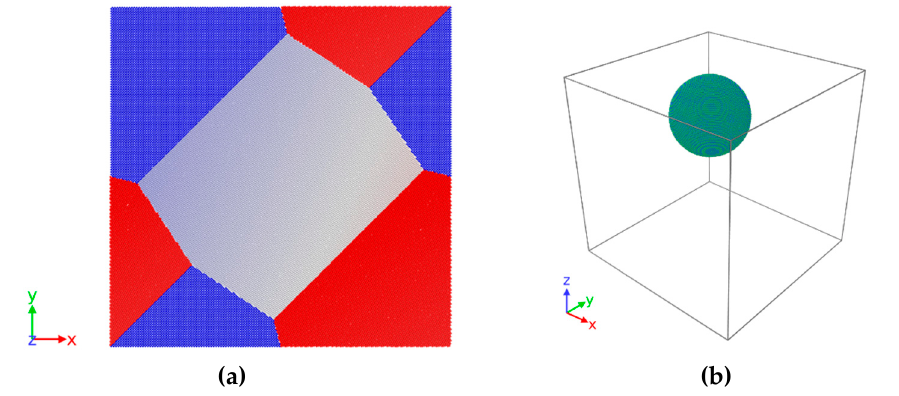
Figure 6. MD model setup. ( a ) Top view of the cubic unit cell 400 × 400 × 400 Å with three ferrite grains and periodic boundary conditions; ( b ) spherical particle of niobium nitride inserted into the cubic cell.